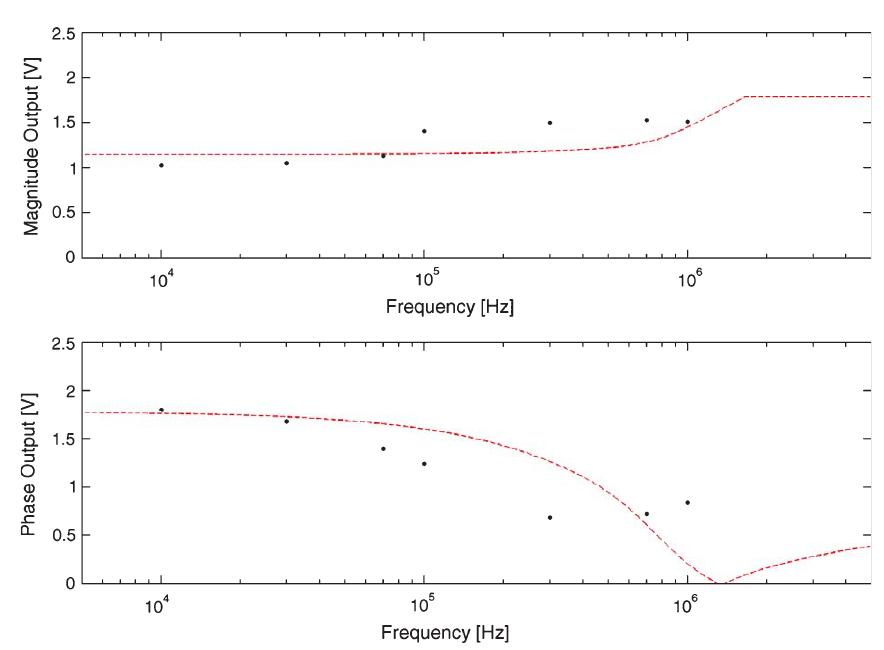
Fig. 15. Magnitude and phase outputs for the R-C model of the spleen. The expected behavior from the SPICE model is also plotted. The measured and modeled behaviors are similar except for a half-decade difference, which indicates an incomplete